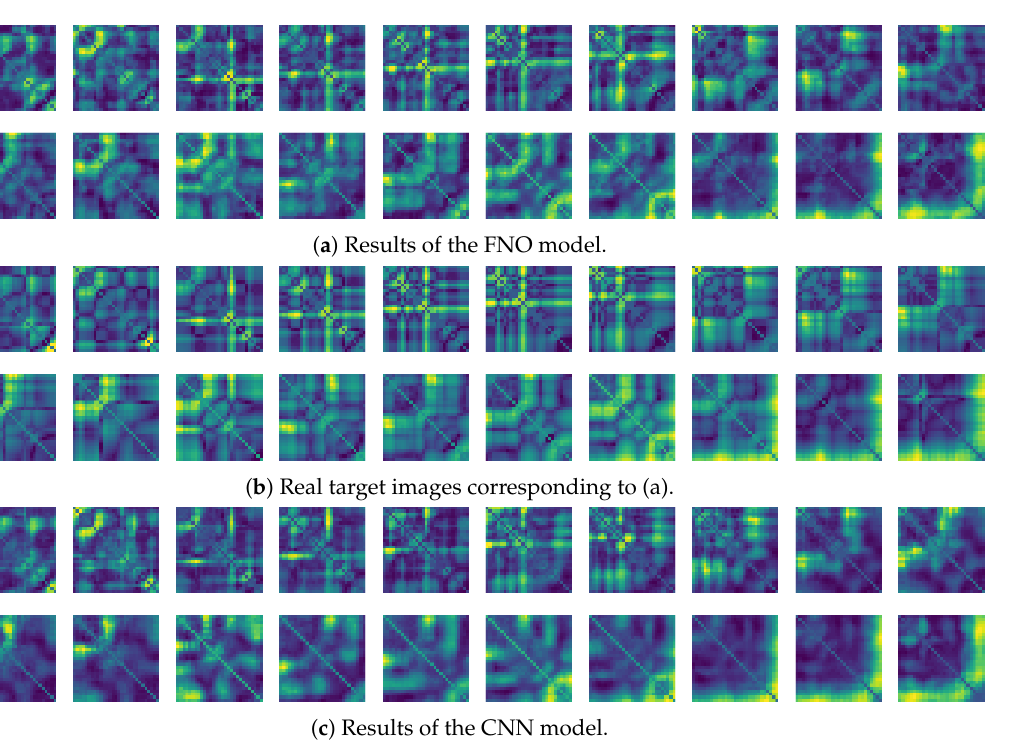
Figure 28. Some samples for walking motion using accelerometer. Table 1. MSE values of the FNO model and CNN model for long-term walking